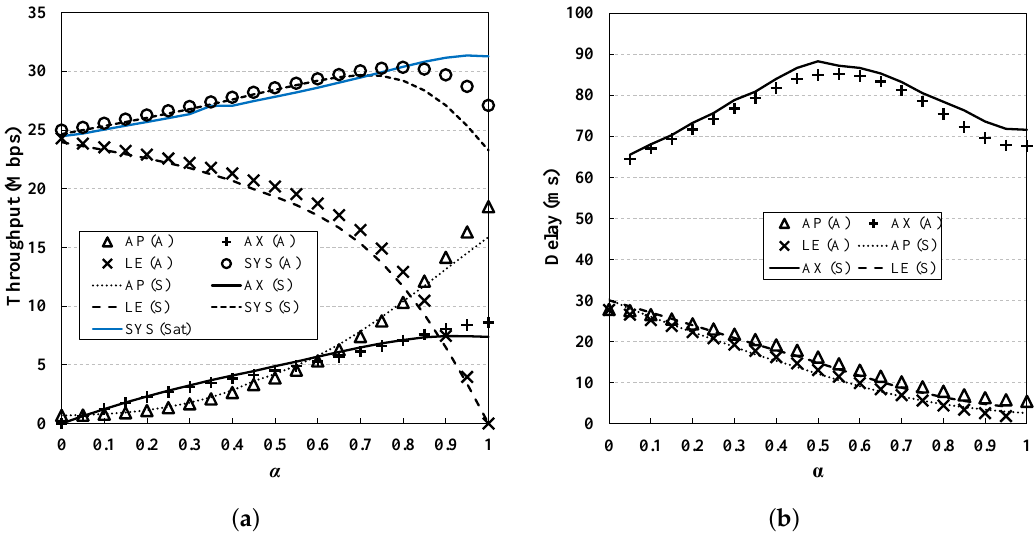
Figure 9. Performance evaluation for different α values. Both the throughput and delay performance improve as α increases, due to the higher efficiency of OFDMA MU transmissions. The system throughput in the case of λ tf = λ data = 250 is depicted in the graph for comparison. ( a ) Throughput; ( b )